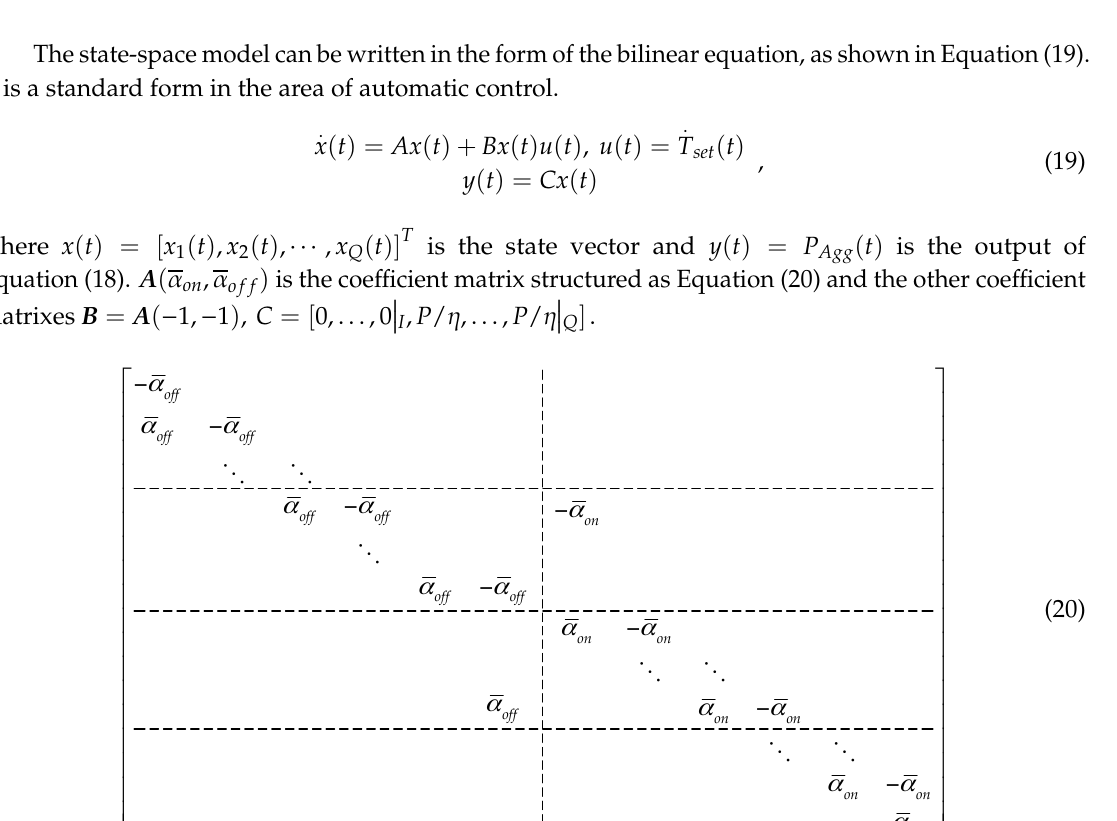
off  . Figure 3. Finite-difference discretization of the system for state-space model derivation. The state-space model is described in Bashash’s study [10] and we do not repeat it.